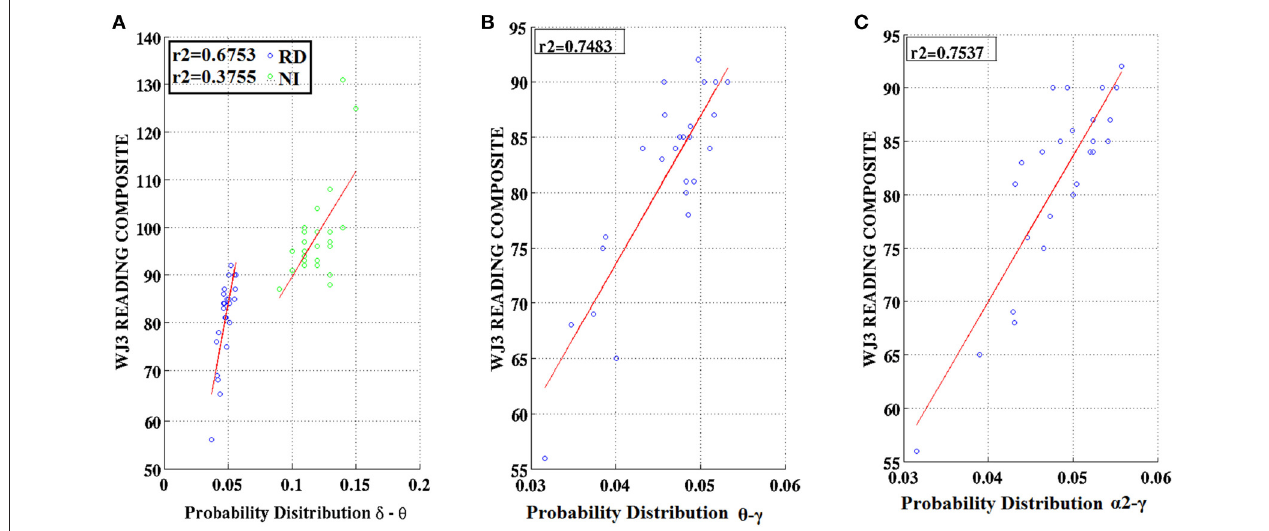
FIGURE 9 | Regression scatter plots of Woodcock–Johnson III (WJ3) Reading Composite scores over Probability Distribution values for three frequency pairs [(A) δ - θ , (B) θ - γ , (C) α 2- γ ] aggregated over right temporo-parietal sensors among RD participants (blue circles; B,C). A significant association noted for NI participants (green circles) is included in (A)